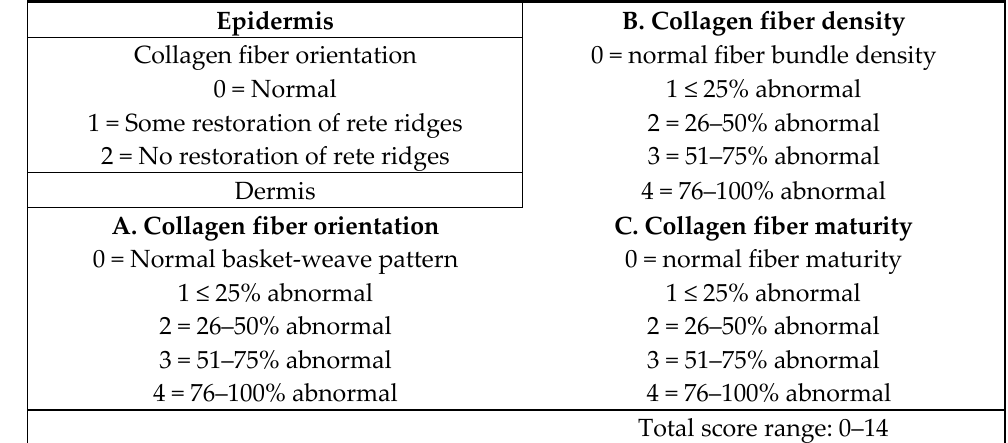
Table 1. Mouse Masson Trichrome Scar Scale (MMTSS).